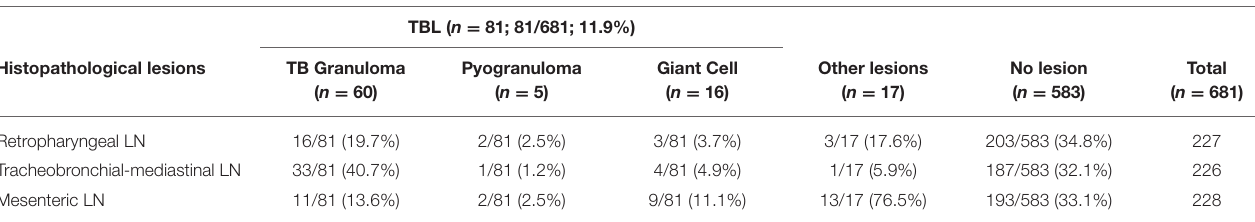
TABLE 3 | Distribution of microscopic lesions in different lymph